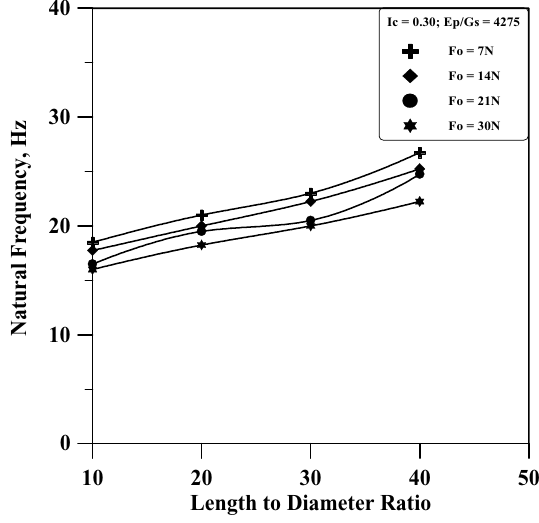
Fig. 9. Variation of natural frequency with pile length.